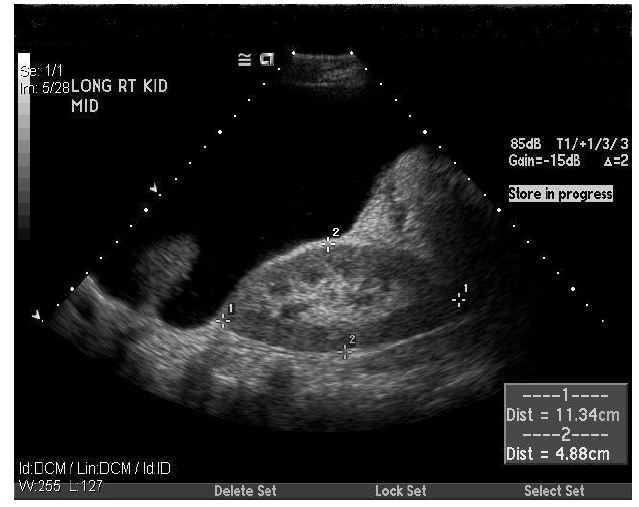
FIGURE 2. USG abdomen shows right kidney with interval resolution of